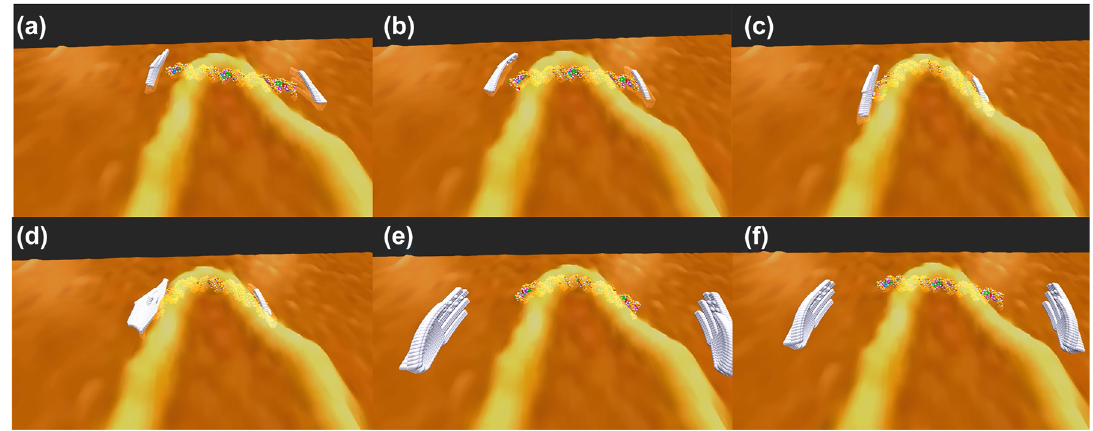
Figure 1: Alignment of a DNA double-strand and an AFM image with virtual hands, bending process (a) and (c), and recovering process (b) and (d): the DNA double-strand returns to its original form when the pressure from the virtual hands is released due to the tensegrity representation [4] of the DNA double-strand in VR simulation.